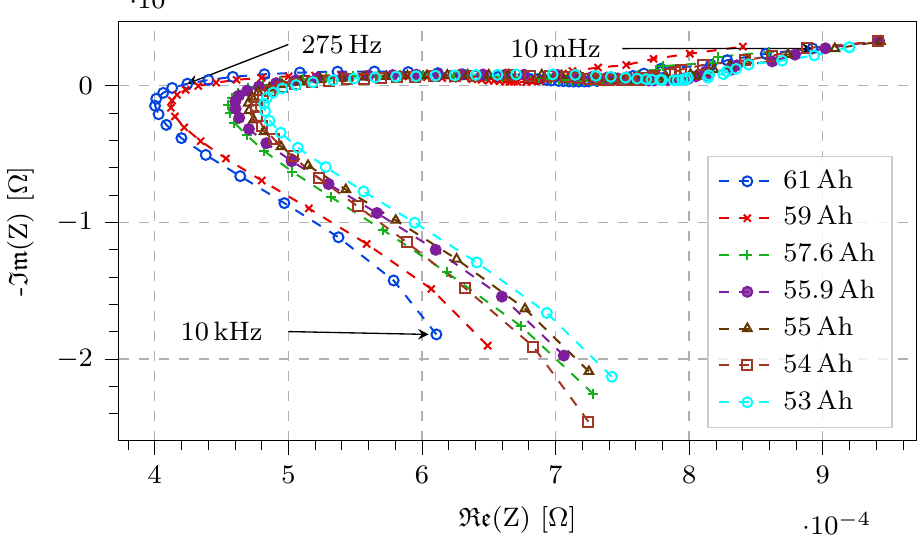
Figure 2. Nyquist plot of cell C1’s impedance with ageing. Measurements taken at 50% SoC and 25°C. Legend shows the measured maximum available capacity.